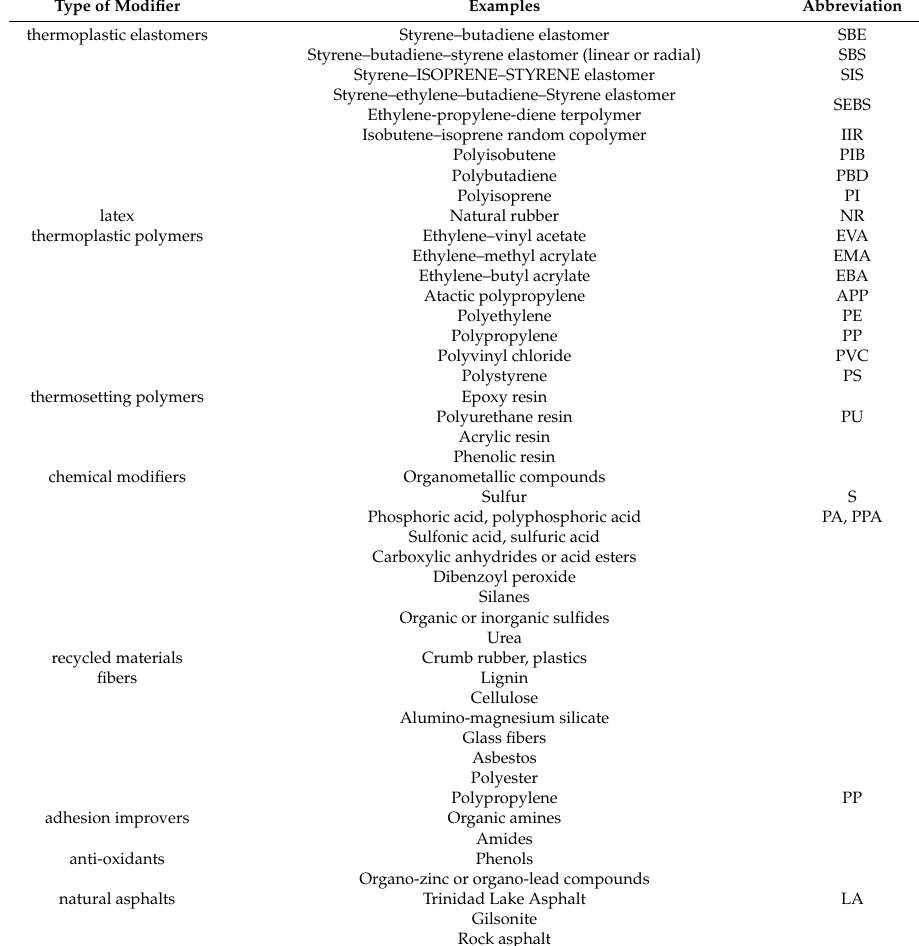
Table 1. Examples of additives used to modify bitumen (reconstructed from [52] with the permission of Thomas